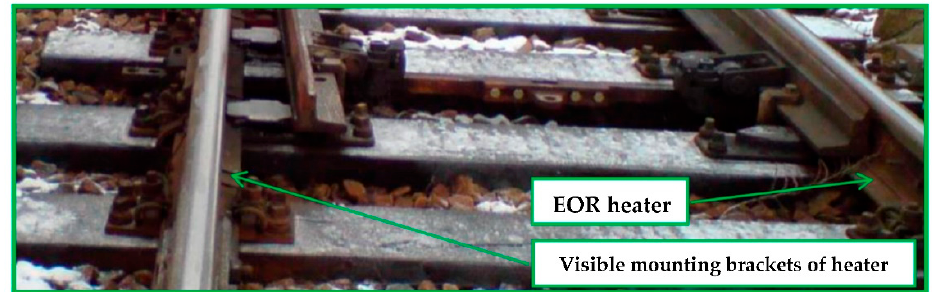
Figure 2. Enlarged area of the photo showing a fragment of the turnout track layout (source: authors).